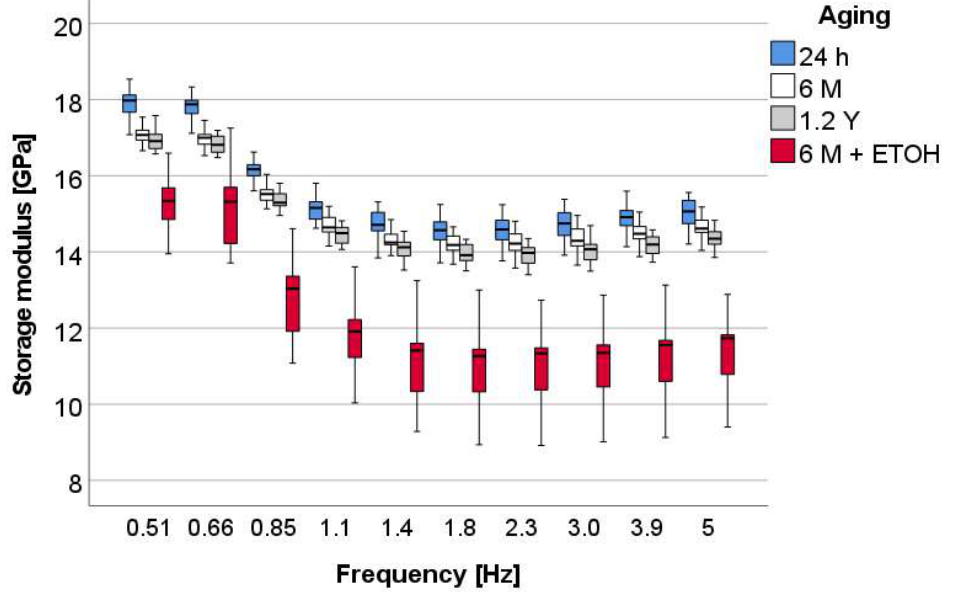
Figure 6. Storage modulus (E′) as a function of frequency and aging method, exemplified for the material OC.